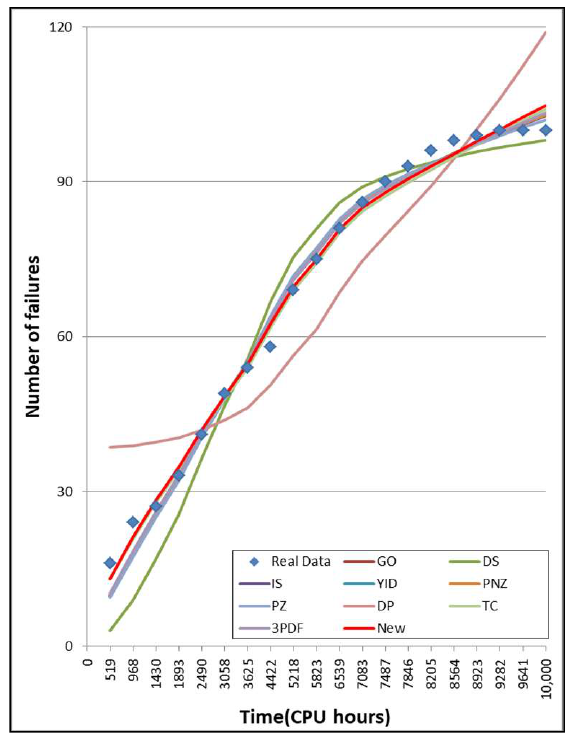
Figure 4. Mean value function of the ten models for DS3.